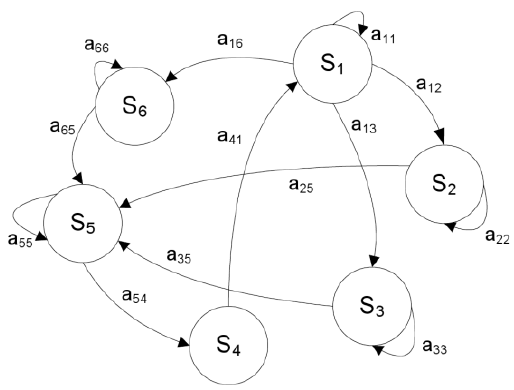
Figure 2. Graphical representation of a six-state Markov chain: the nodes are the states of the chain; the oriented arcs between nodes denote state-to-state transitions, including